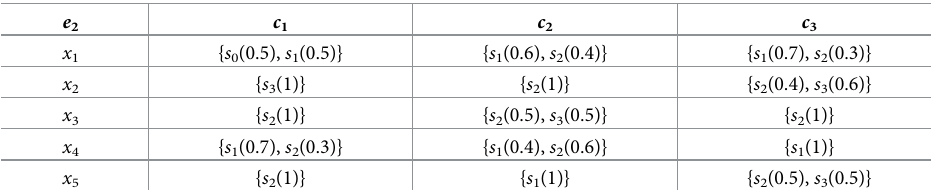
Table 2. The decision matrix of e 2 .